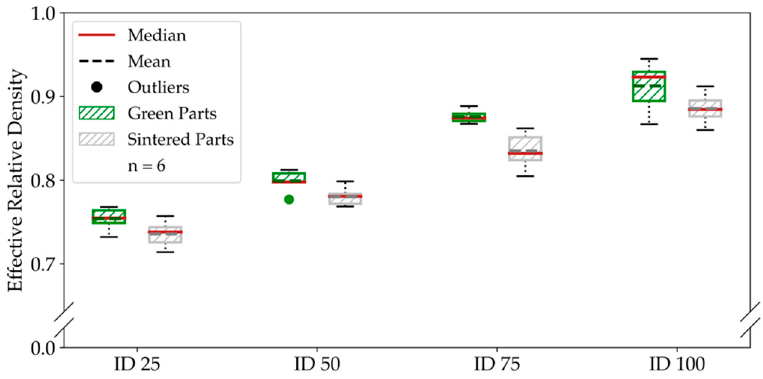
Figure 6. Effective relative density of the bending specimens. The comparison of the density before and after sintering shows a decrease in the relative density for the sintered parts. and after sintering shows a decrease in the relative density for the sintered